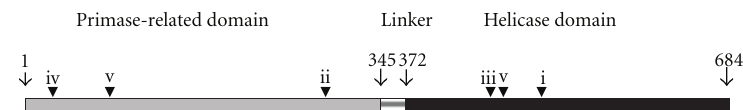
Figure 1: Schematic representation of the c10orf2 gene showing the locations of previously reported recessive mutations: (i) Y508C [3], (ii) A318T [4], (iii) T451I [5], (iv) R29X [6], and (v) P83S/R463W [Current